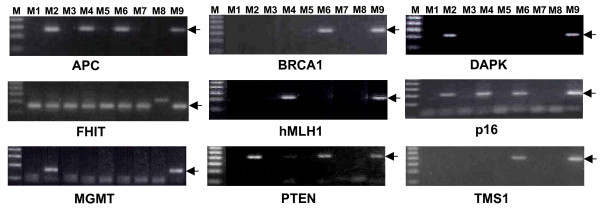
Identification of CpG island hypermethylation by pooled DNA approach and MSP. Methylated alleles for some gene loci produced by MSP in tumor and normal DNA pools of the three types of gynecologic cancer. M: 50 bp DNA marker; M1 and M2: normal DNA and tumor DNA pools of cervical cancer; M3 and M4: normal DNA and tumor DNA pools of endometrial cancer; M5 and M6: normal DNA and tumor DNA pools of ovarian cancer; M7: a sodium bisulfite-treated placenta DNA, but without pre-treatment of SssI methyltransferase; M8: an un-treated placenta DNA; M9: a placenta DNA treated with SssI methyltransferase followed by sodium-bisulfite. The arrows indicate the positions of the PCR products.